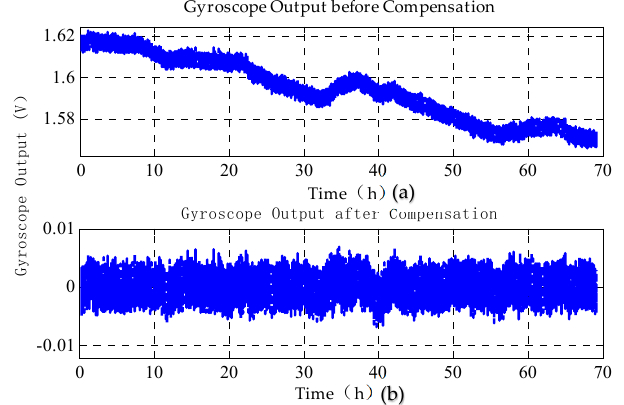
Figure 15. Comparison of the bias drift: ( a ) bias before compensation and ( b ) bias after being compensated by the BP neural network.